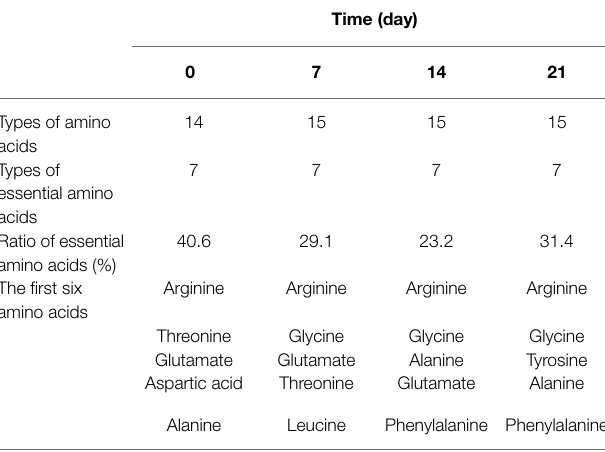
TABLE 1 | Species and composition of amino acids in fermentation